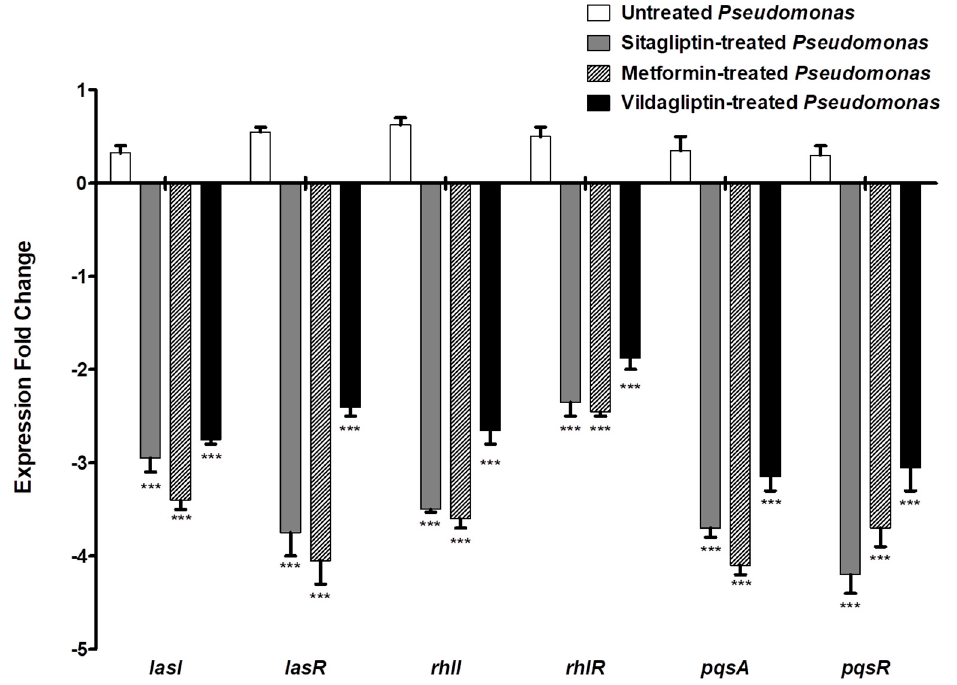
Figure 3. Down-regulation of P. aeruginosa QS genes. RNA was isolated from P. aeruginosa cultures treated and untreated with anti-diabetic drugs in sub-MIC to be used in cDNA synthesis. The cDNA was amplified by qRT-PCR and changes in the expression of each QS gene that were normalized in relation to the mean critical threshold values of housekeeping gene rpoD . Expression fold change in gene expression in anti-diabetic treated P. aeruginosa was calculated by the 2 − ∆∆ CT method and compared to untreated bacteria. The data shown are the mean ± standard errors from three experiments. p < 0.05 was considered significant using the one-way ANOVA test. Three tested drugs significantly decreased the expression of genes lasI , lasR , rhlI , rhlR , pqsA and pqsR ( p < 0.0001). ***: p ≤ 0.001.